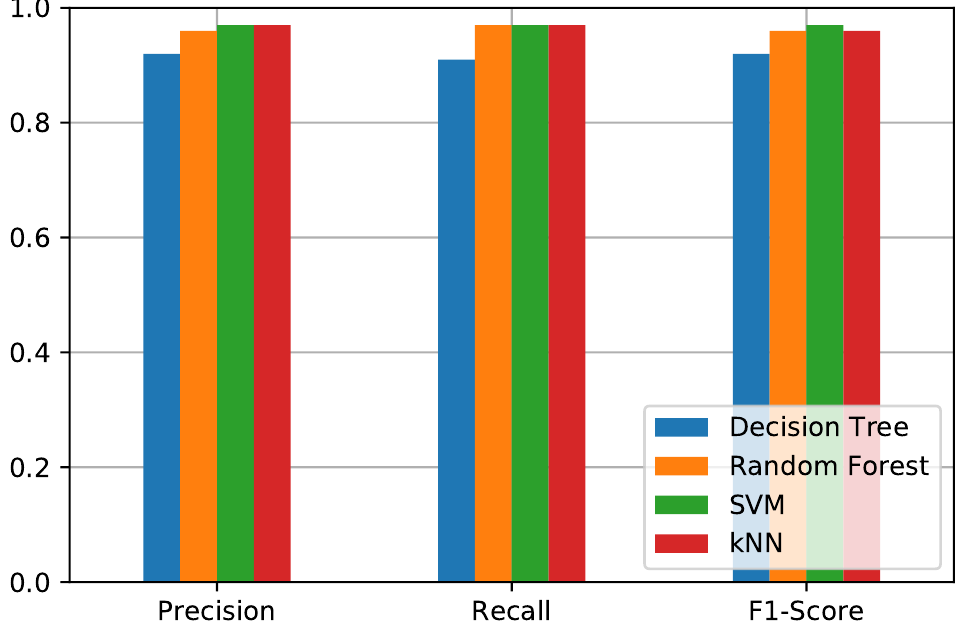
Figure 10. Q2—Precision, Recall, and F1-Score to predict the employment status.